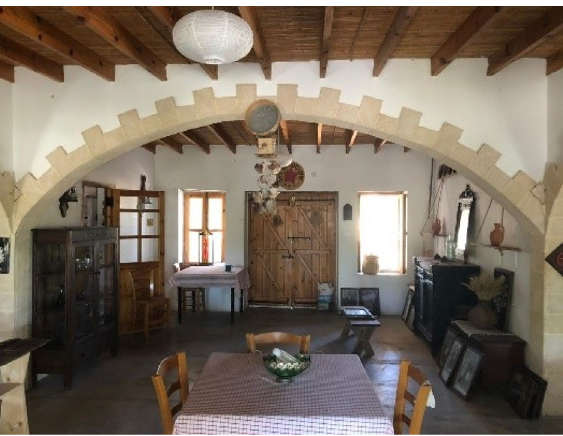
Fig. 17 Ayphodios Guest House. Authentic furnishing example — Komikebir.